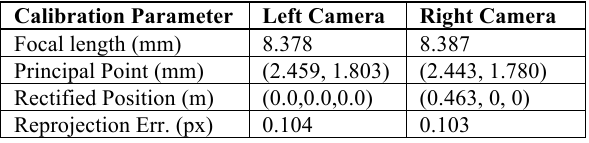
Table 1 Calculated stereo camera calibration parameters